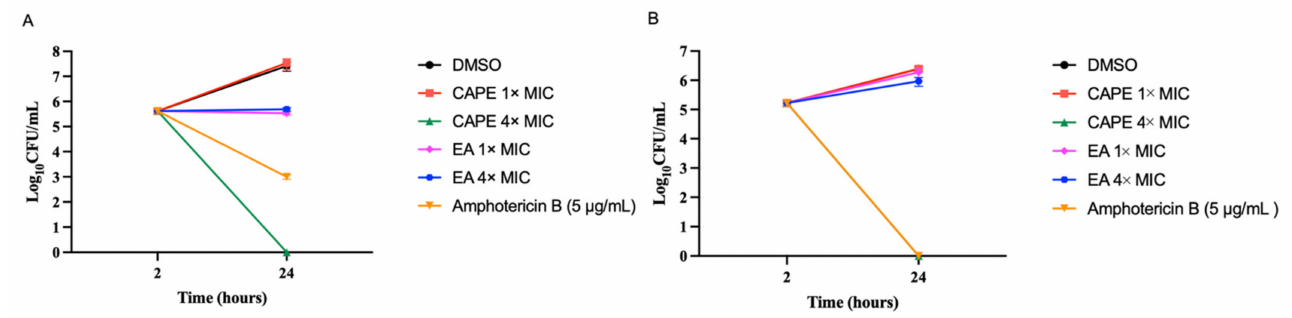
Figure 6. Effects of EA and CAPE on C. auris ( A ) and C. albicans ( B ) virulence using the cell line A549. The results are reported in log CFU/mL. The compounds were dissolved in DMSO, and the amount of DMSO used as the solvent for the compounds was used as a control. Amphotericin B was used as a positive